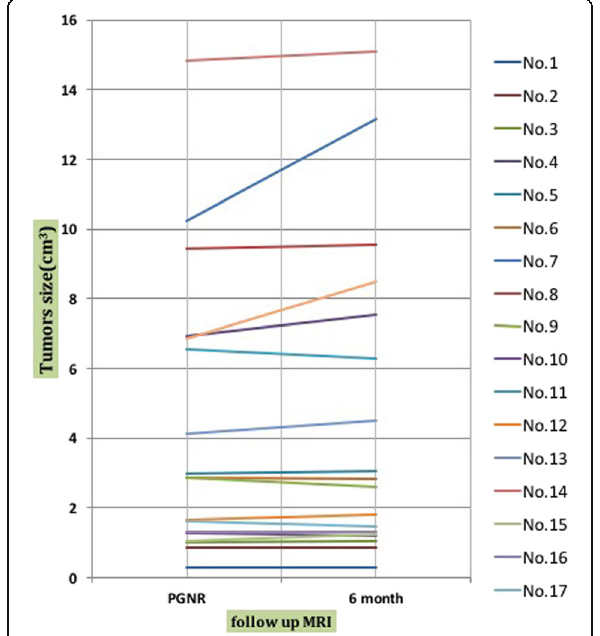
Fig. 4 Linear chart shows tumors volumetric changes after 6 months of GNRS